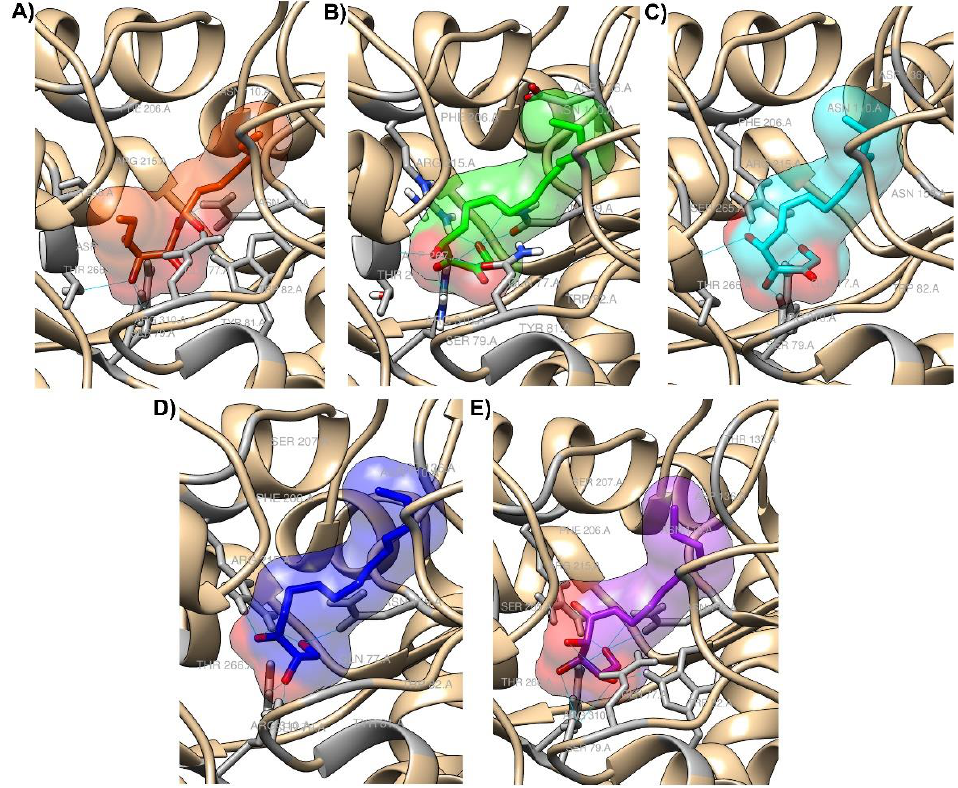
Figure 3. Docked poses of top five potential hits in the active site of